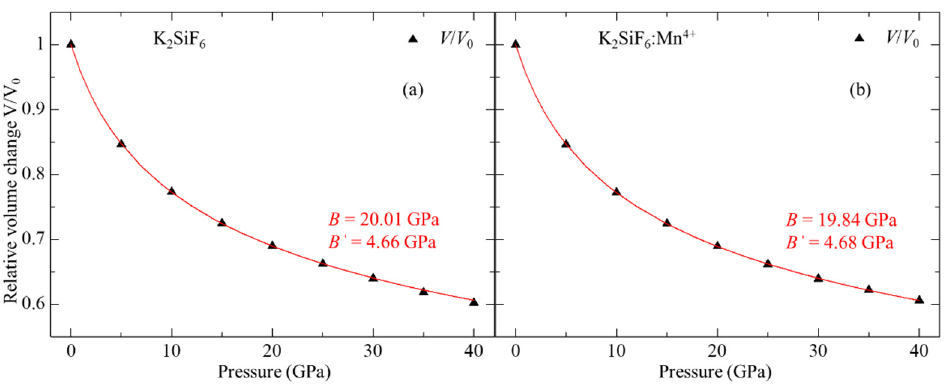
Figure 1. Calculated relative volume V / V 0 of ( a ) non-doped and ( b ) Mn 4+ -doped K 2 SiF 6 as a function of pressure. Red solid curves denote fitting results to the Murnaghan’s equations of state.